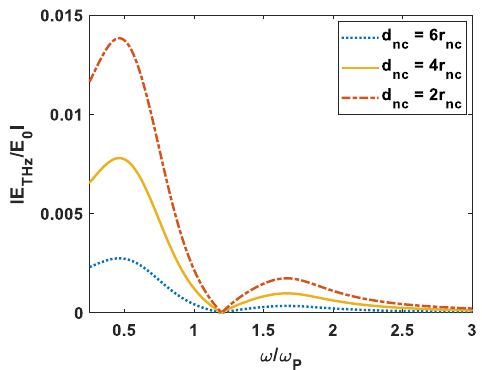
Figure 6. Variation of emitted THz radiation field with normalized frequency for different inter- particle distance of the adjacent nanocylinders with their basal planes parallel to the incoming electric field, when h nc = 5 r nc , E 0 = 4.0 × 10 10 V/m, a 0 = 2.0 × 10 − 5 m and y = 0.95 a 0 .